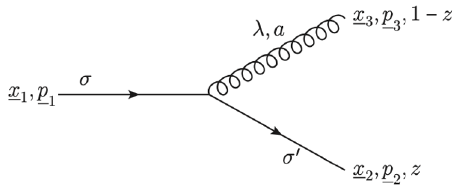
Figure 1 . The diagram contributing to the leading-order light-cone wave function for the q → qG